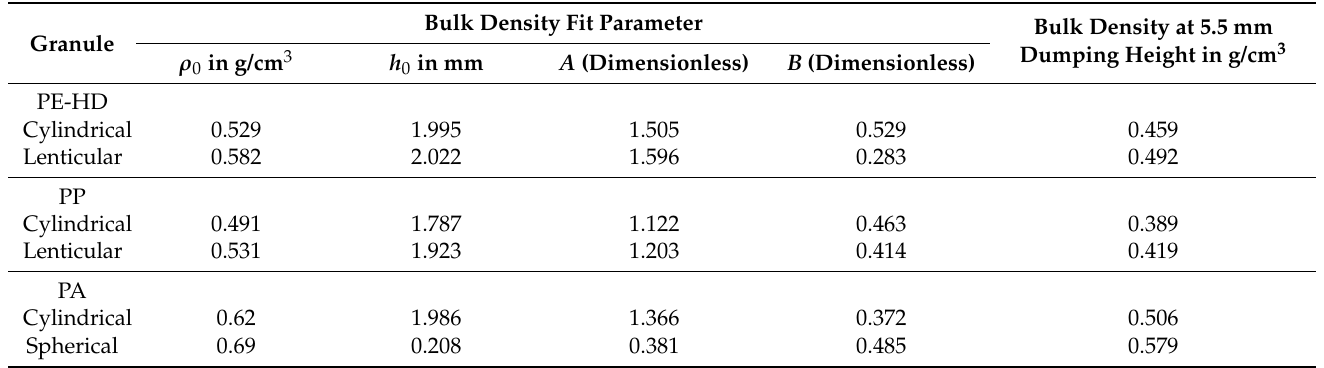
Table 3. Bulk density fitting parameters for all used plastic granules based on Equation